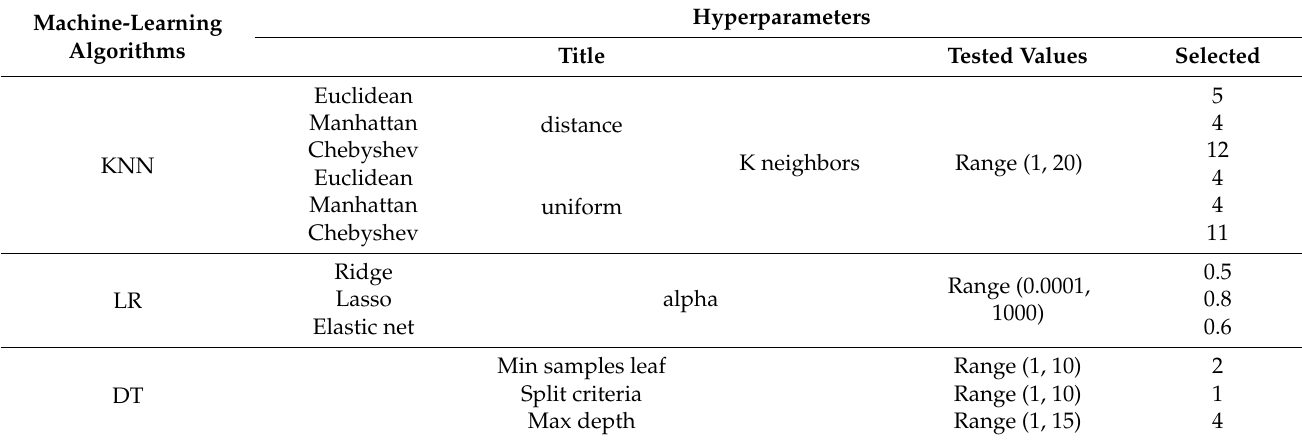
Table 2. Hyperparameters considered for developing machine-learning predictive models.